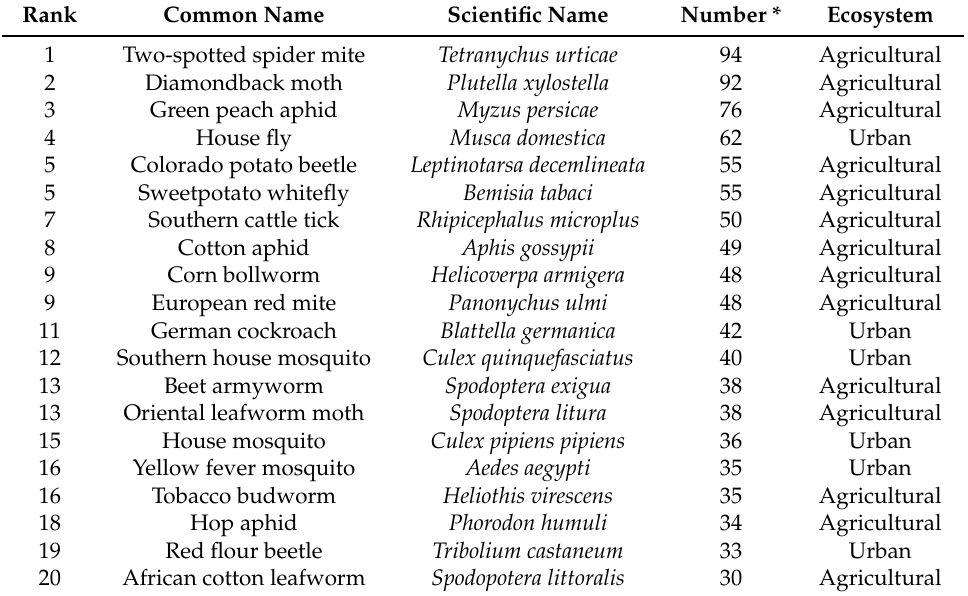
Table 1. Top 20 resistant arthropods in agricultural and urban ecosystems [7] (permitted kindly by Drs. Mark Whalon and David